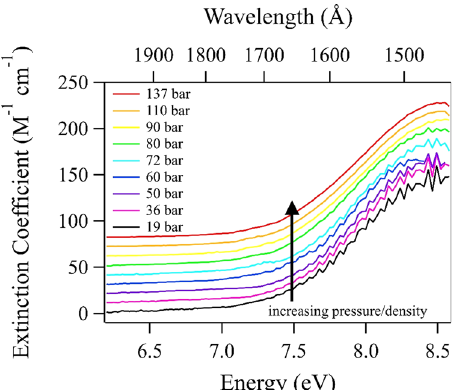
Fig. 2 Supercritical CO 2 VUV spectra. Spectra were acquired at 308 K at pressures/densities as listed in Table 1. Spectra are arti fi cially offset in increments of 10 M − 1 cm − 1 for viewing.